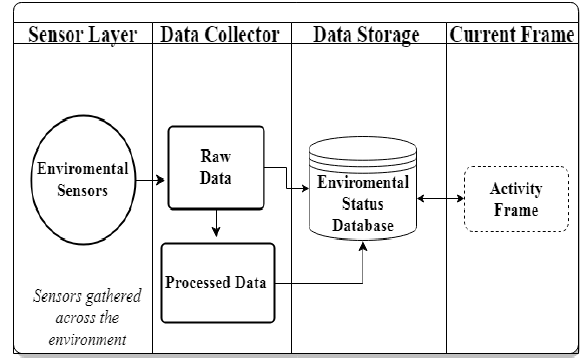
Figure 5: An example of activity frame.